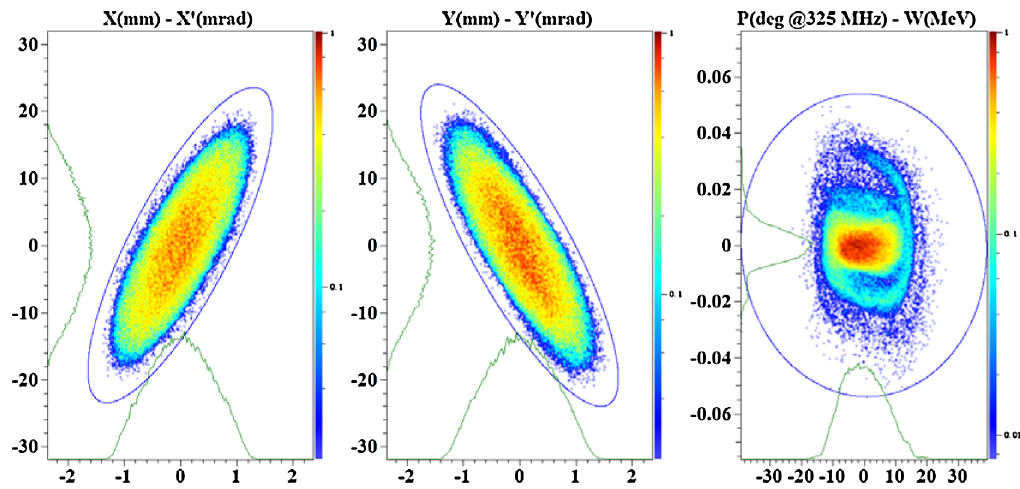
FIG. 8. Phase distributions at the exit of RFQ for the Injector Scheme-I (plotted with TRACEWIN